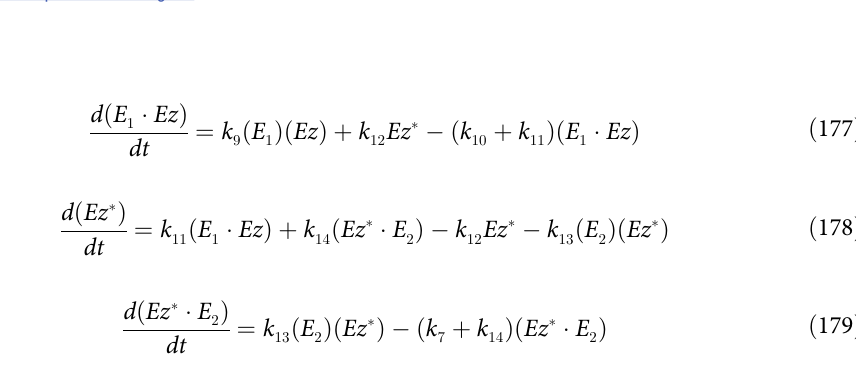
= k /( k + 5 5 k 17 17 is set